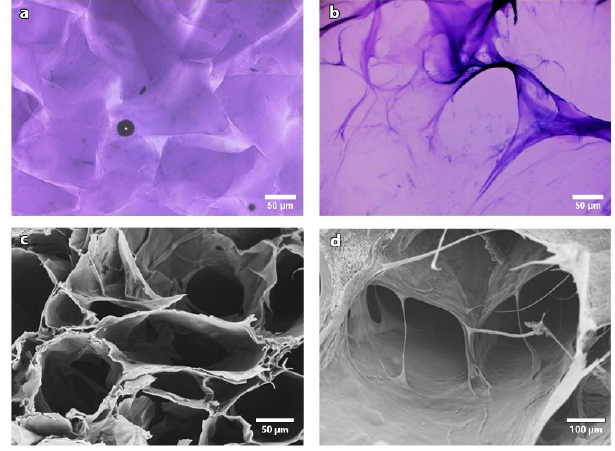
Figure 3. 10× optical images of a ( a ) classical biphasic hydrogel and ( b ) sample HA30. SEM images of sample HA30 ( c , d ). Table 3. Degradation parameters of analyzed hydrogels containing 20 or 30 mg/mL hyaluronic acid (HA). R 2 : determination factor for the data fitting evaluation; Deg Max (%): maximum percentage of HA degradation contained in hydrogels; T 1/2 (h): time to reach the 50% of the Deg